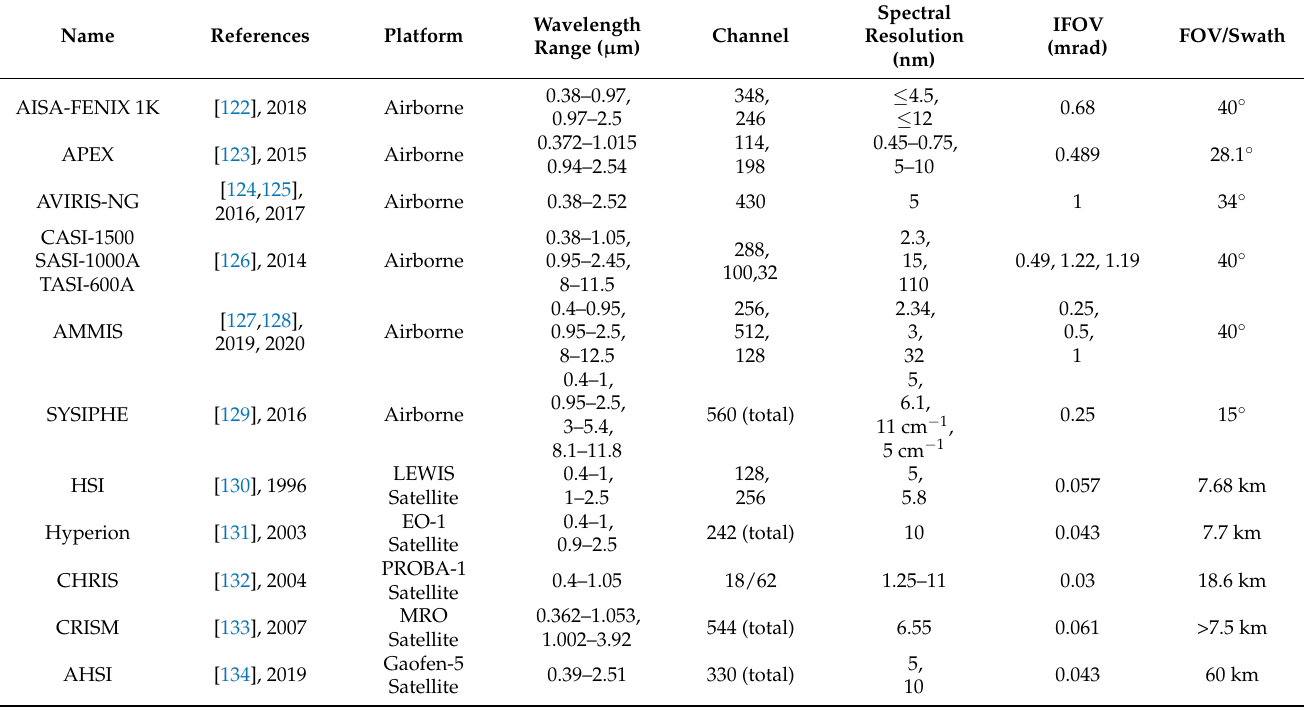
Table 2. Typical airborne and spaceborne hyperspectral